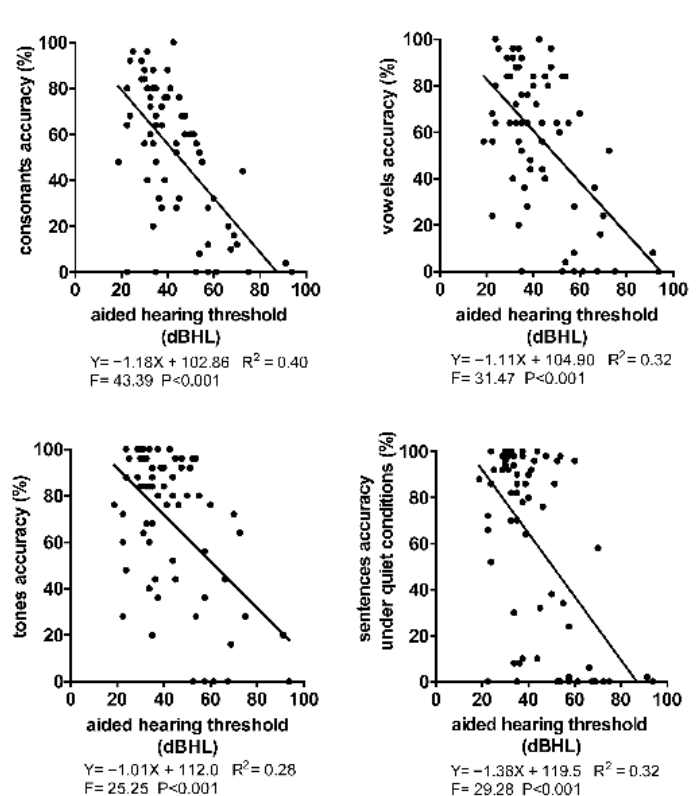
Figure 2. The linear relationship between AHT and SPA in 49 CI subjects. Among the 49 CI subjects, 16 CI with HA dual-mode subjects and 6 bilateral CI subjects were evaluated. Therefore, a total of 71 hearing-aided ears were included for analysis. R 2 was the goodness of fit, and F was the result of the variance test for the regression model. p < 0.05 indicates a linear relationship between AHT and SPA.